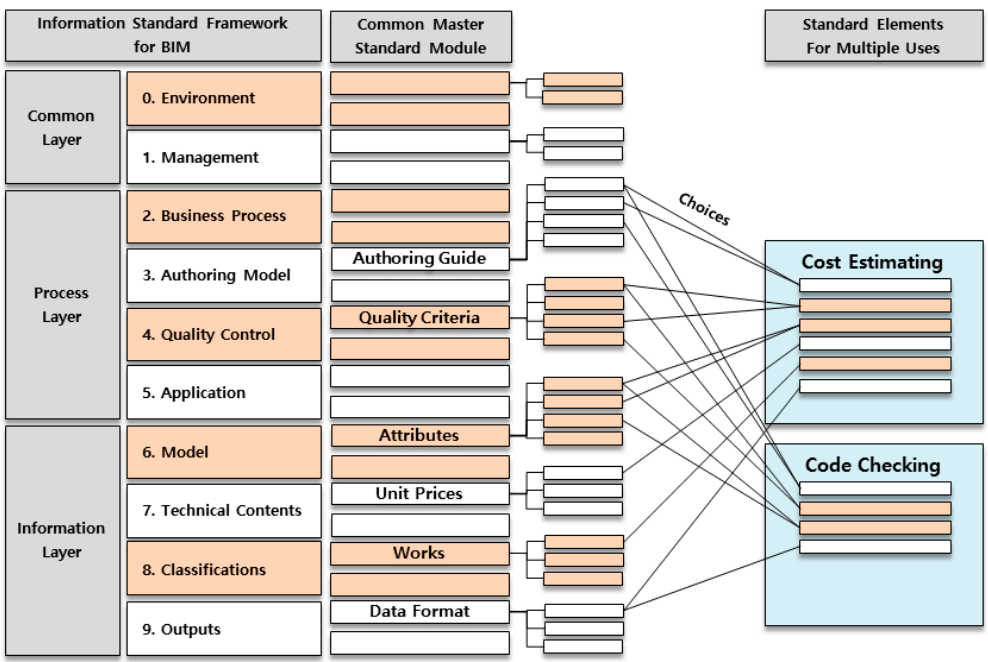
Figure 6. Concept of using the common master standard for cost estimating and code checking.